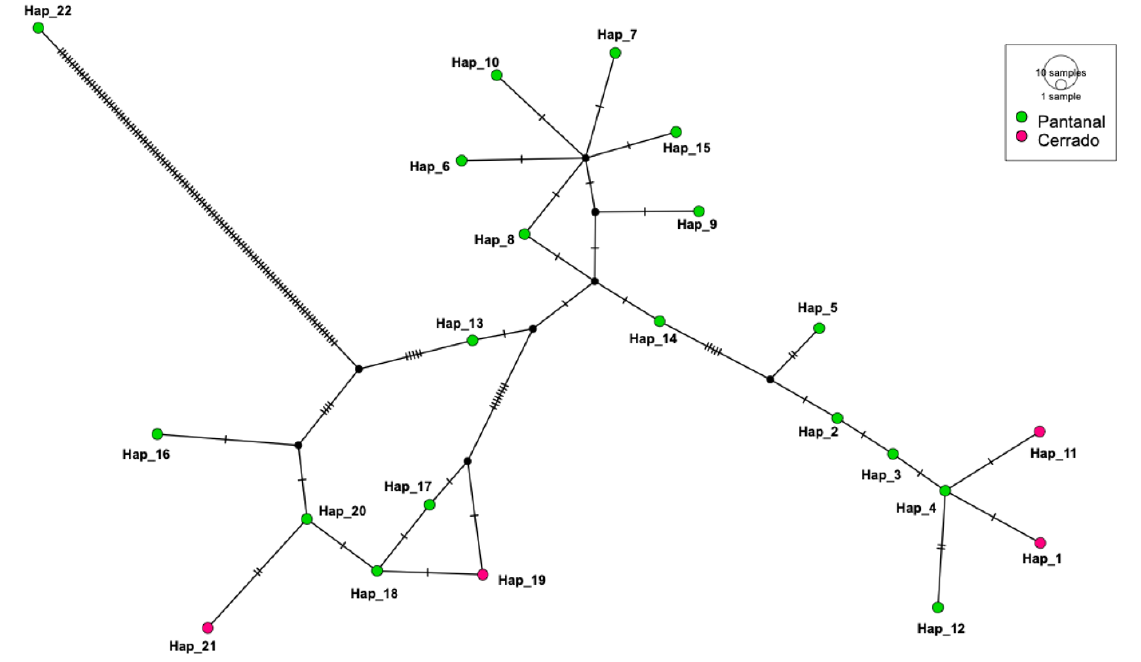
Figure 5. Genotype diversity among 16S rRNA gene sequences detected herein. Analysis was made using DnaSP6. Inference and graphic representation were made by TCS network method on PopART software. Genotypes in blue were obtained from samples from tapirs in Pantanal regions meanwhile genotypes in green were obtained from samples from tapirs in Cerrado regions. Table 6. Values obtained regarding genotype diversity by DnaSP software and based on partial hemoplasma 16S rRNA sequences detected in tapirs from the present study.